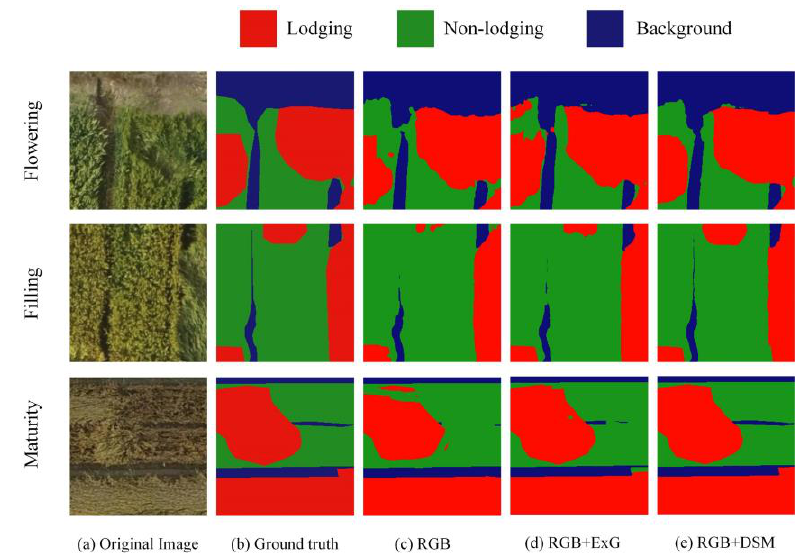
Figure 8. Test results of lodging recognition using different data.